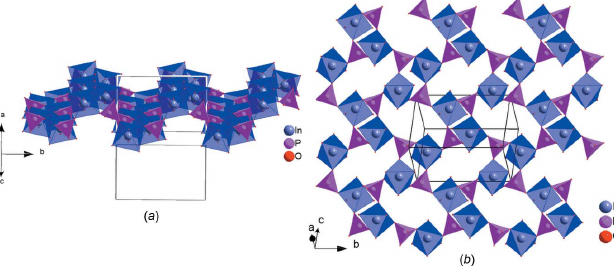
Figure 3 ( a ) A view approximately along [101] showing the undulating layer